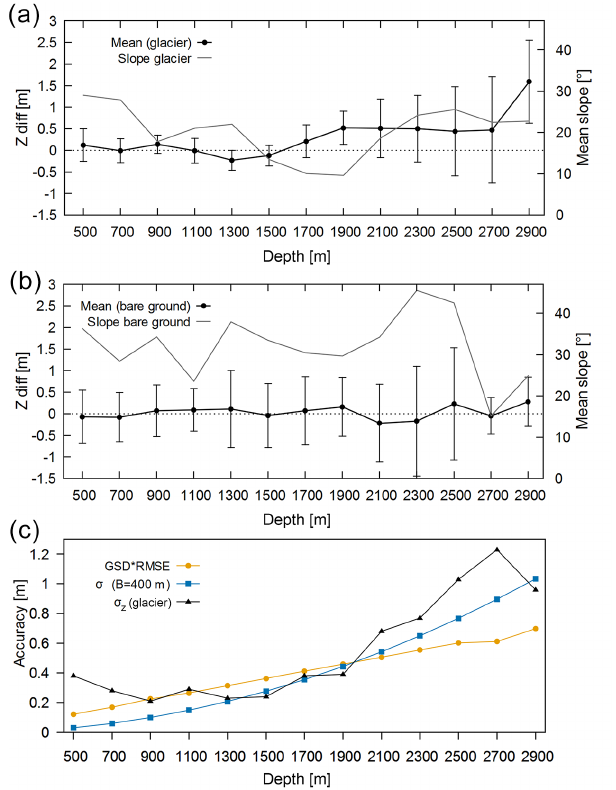
Figure 10. Mean and standard deviation of the 2014 DoD between SfM–MVS and ALS-based DEM depending on the distance from the camera depth (a) within the glacier area and (b) in the bare ground outside the glacier covered by rock. The trend of the aver- age slope angle for each depth interval is shown on the right y axis. Panel (c) : comparison of σ z measured within the glacier area, the theoretical depth accuracy estimated according to Eq. (1) and the GSD multiplied by the GCP RMSE for each depth interval.